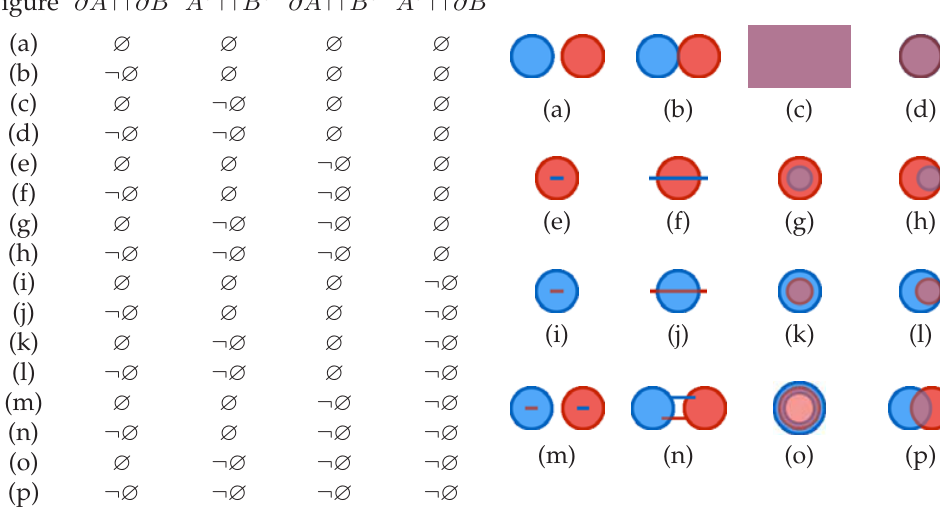
Figure 5: The sixteen different relations identified by the 4 -intersection with a graphical instantiation of each. Wherever possible, the relation is expressed with a pair of simple regions